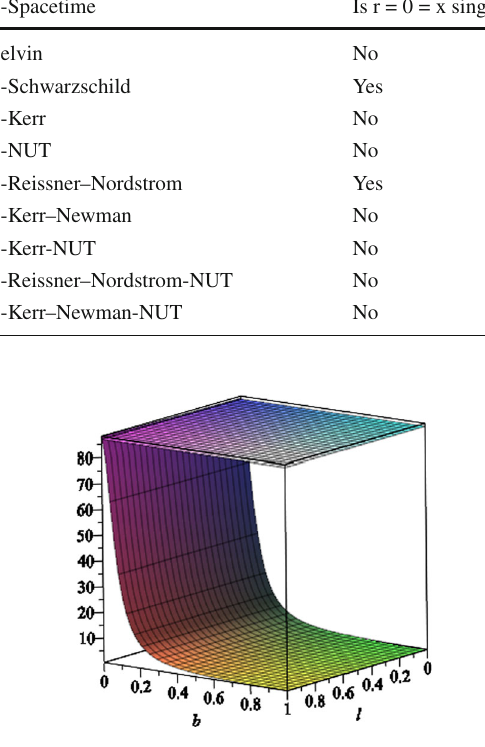
Fig. 1 The equatorial circumference C x = 0 versus the NUT charge l and the magnetic field b , where we set the other black hole parameters a = 6 , m = 7 and q = 1. The horizontal plane shows the equatorial circumference (which is equal to 87 . 4 in arbitrary unites), where the NUT charge and the magnetic field are zero